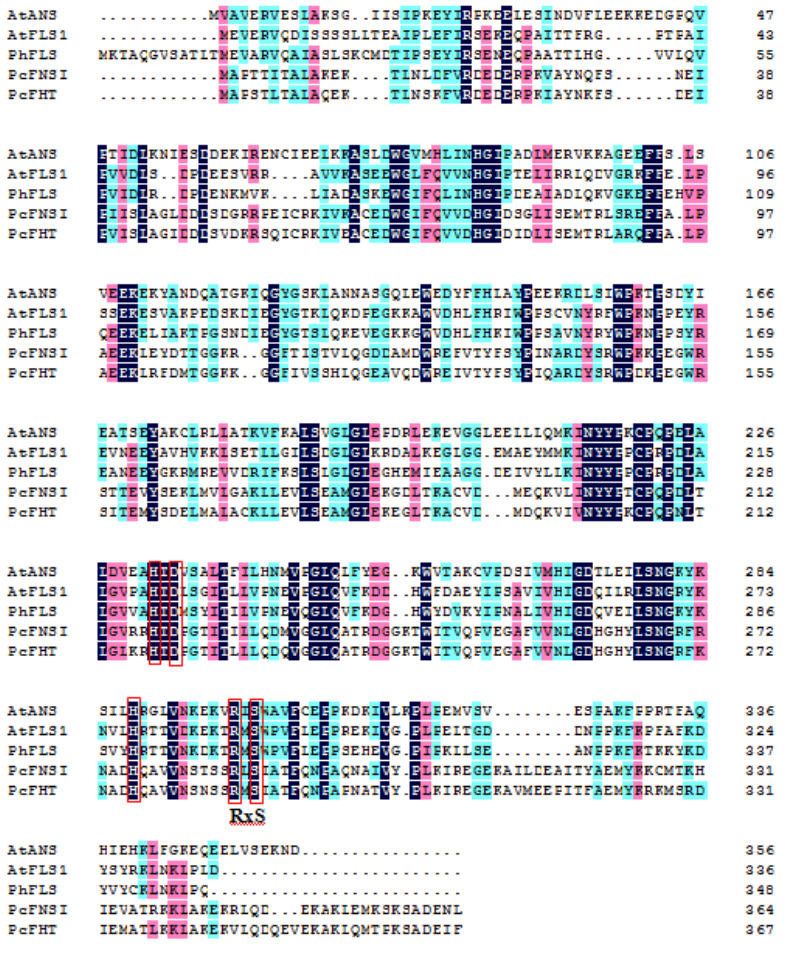
Figure 4. Alignment of the deduced amino acid sequence of different 2-ODDs. Multiple sequence alignment was calculated with the DNAMAN package. Black shading shows amino acid identities. The catalytic residues conserved in these 2-ODDs are indicated in red boxes. The abbreviations for species and accession numbers are: AtANS ( Arabidopsis thaliana AJ564262), AtFLS1 ( Arabidopsis thaliana AAB41504), PhFLS ( Petunia hybrida CAA80264), PcFNS I ( Petroselinum crispum AY817680), and PcFHT ( Petroselinum crispum